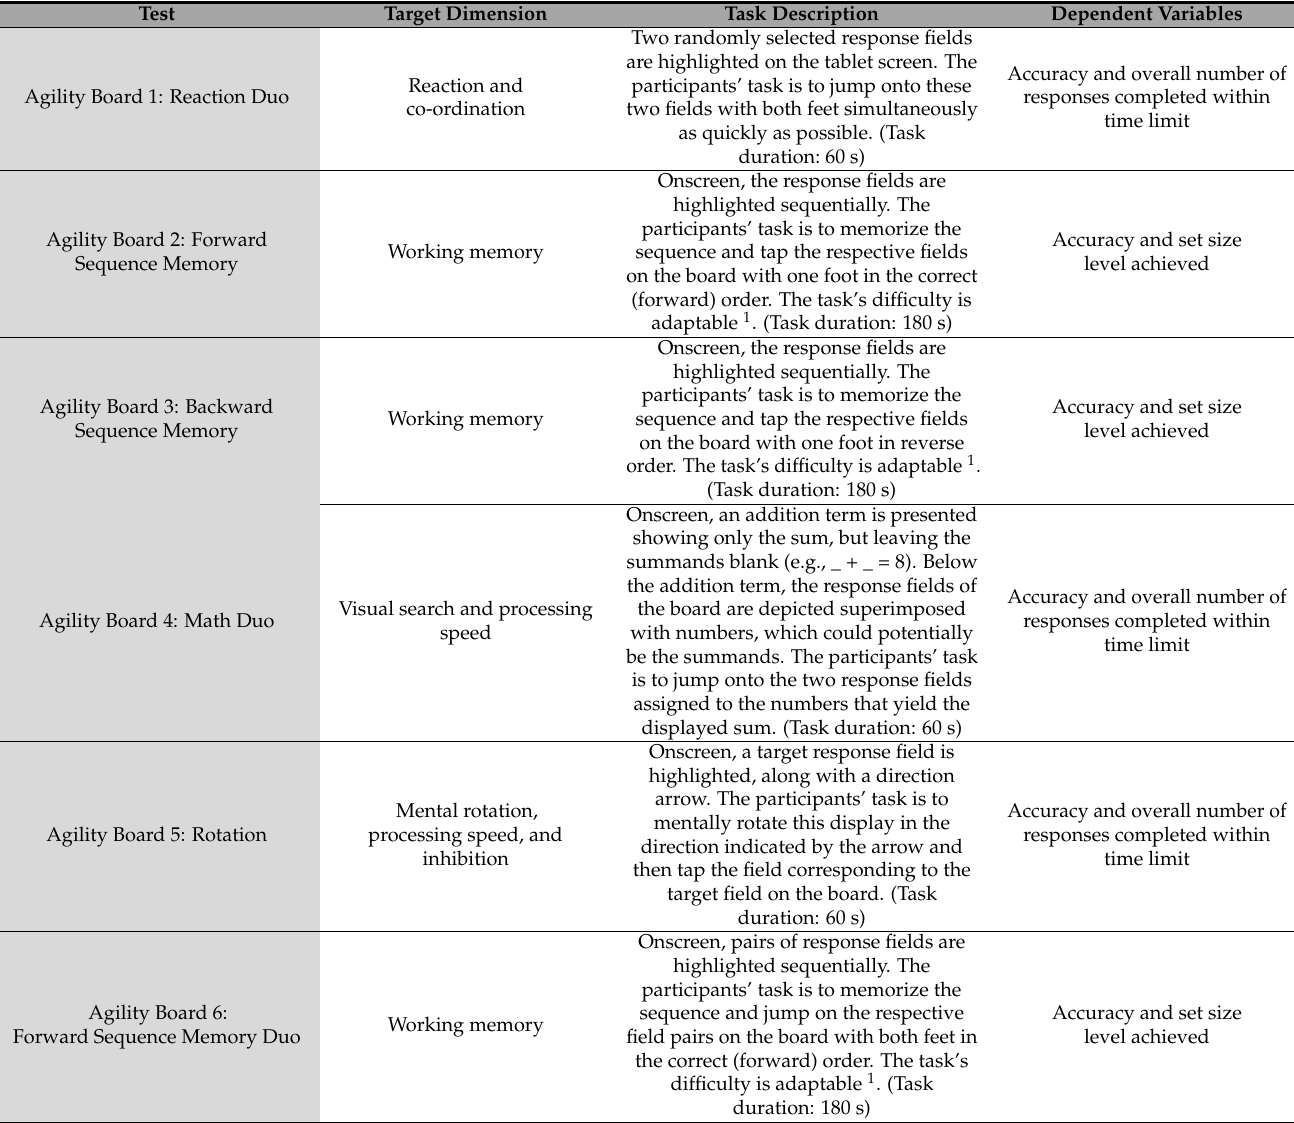
Table 2. Measure of motor–cognitive skills using the Agility